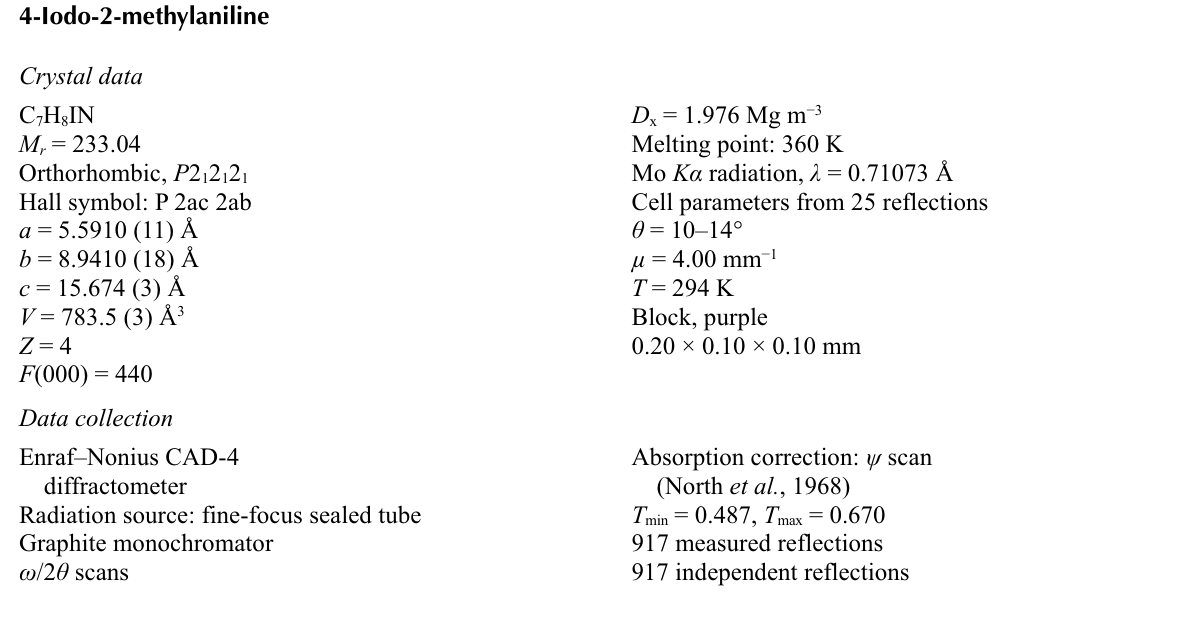
A packing diagram of (I). Hydrogen bonds are shown as dashed